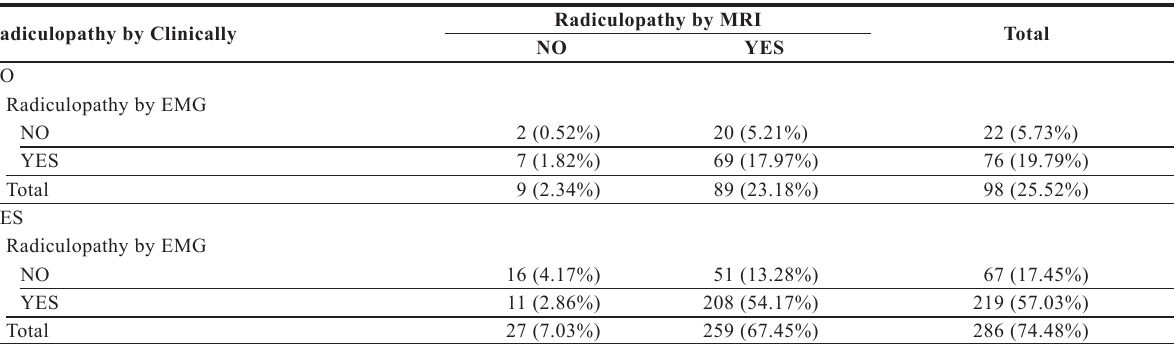
Radiculopathy by MRI